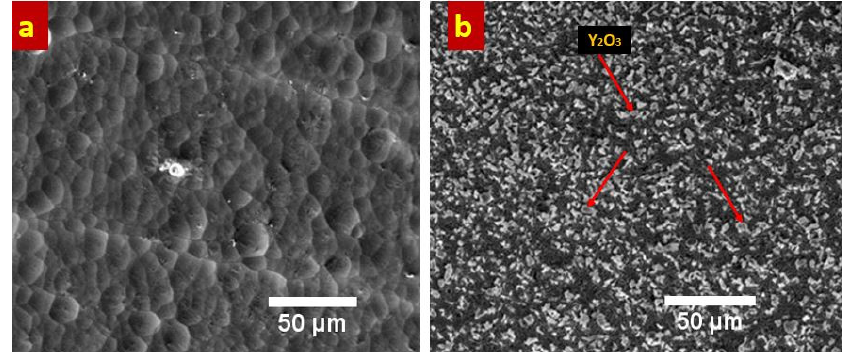
Figure 3. Coating morphology; FESEM images of electrodeposited Ni ‐ B ( a ) and Ni ‐ B ‐ Y 2 O 3 composite coatings with arrowheads indicating incorporated Y 2 O 3 particles ( b ).